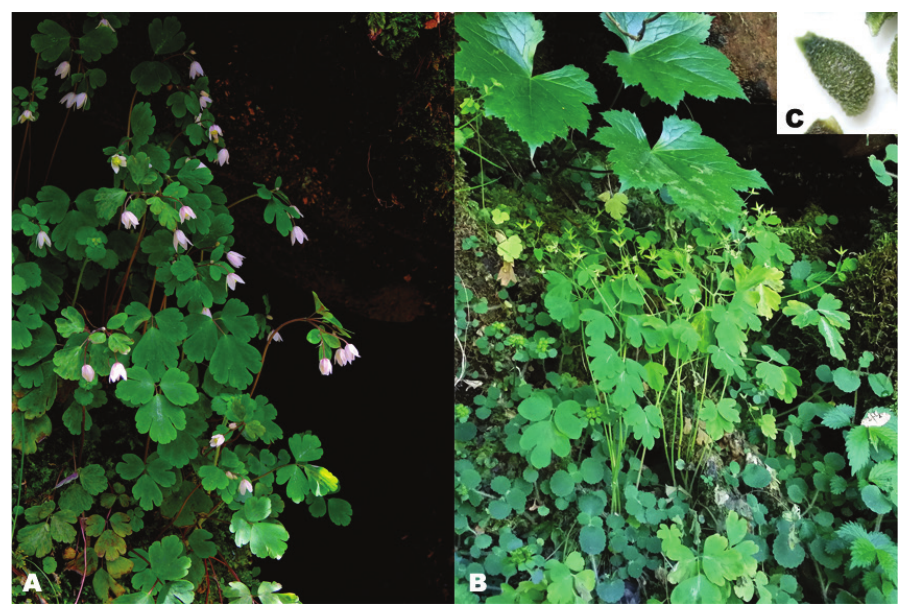
Figure 2. Semiaquilegia quelpaertensis D.C. Son & K. Lee, photographs. A Flowering plant B Fruiting plant C Seeds. Photographs by Kang-Hyup